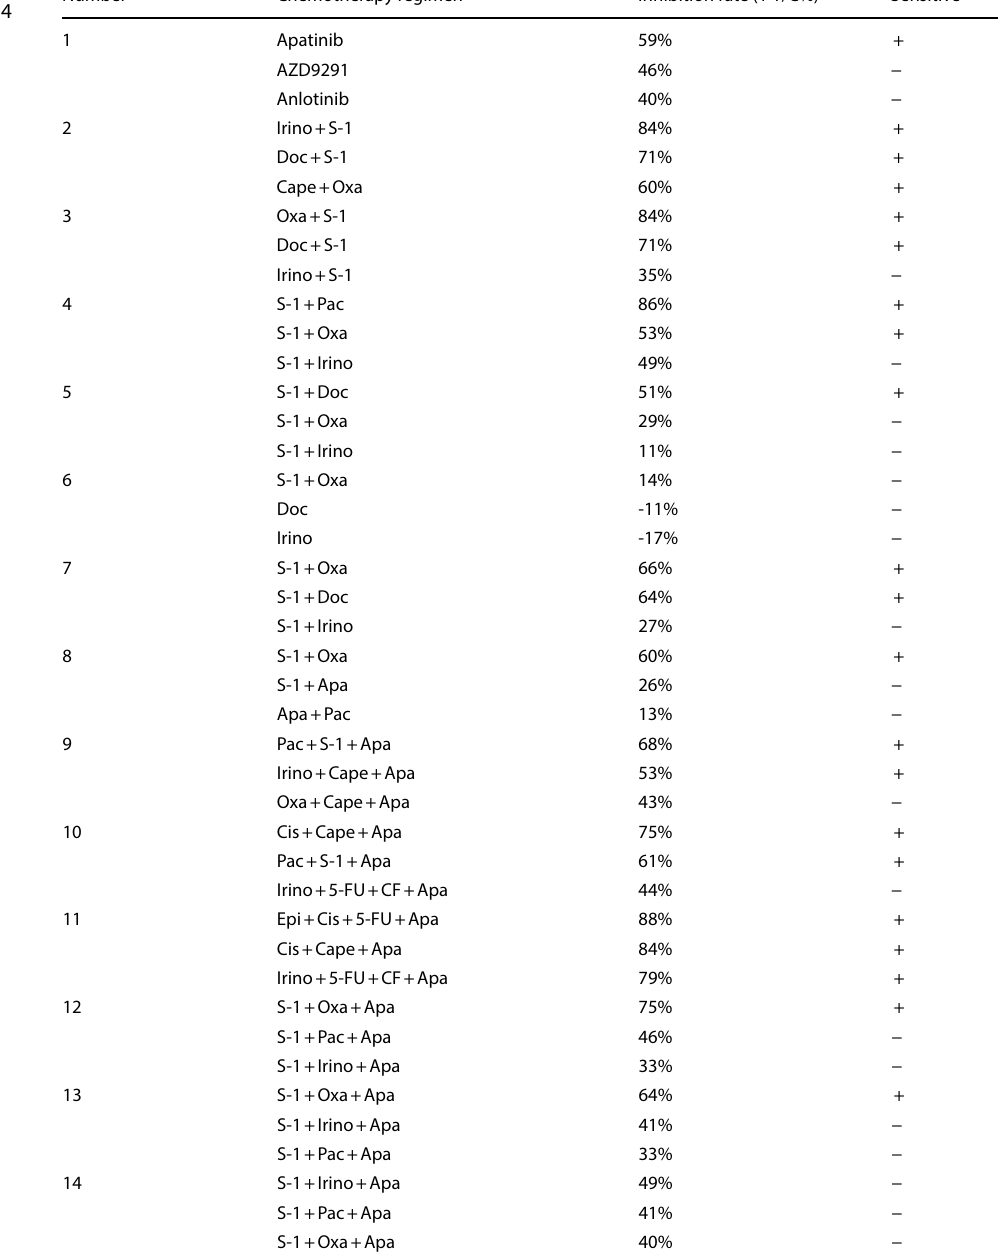
Table 3 Mini-PDX Drug Sensitivity Results for the 14